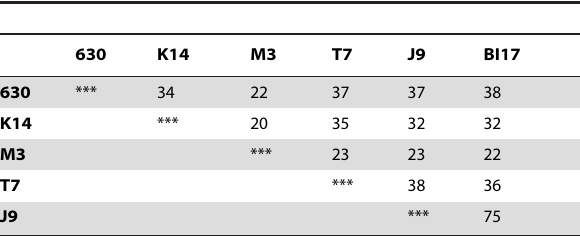
Table 2. SlpA Low Molecular Weight (LMW) subunit sequence variation.